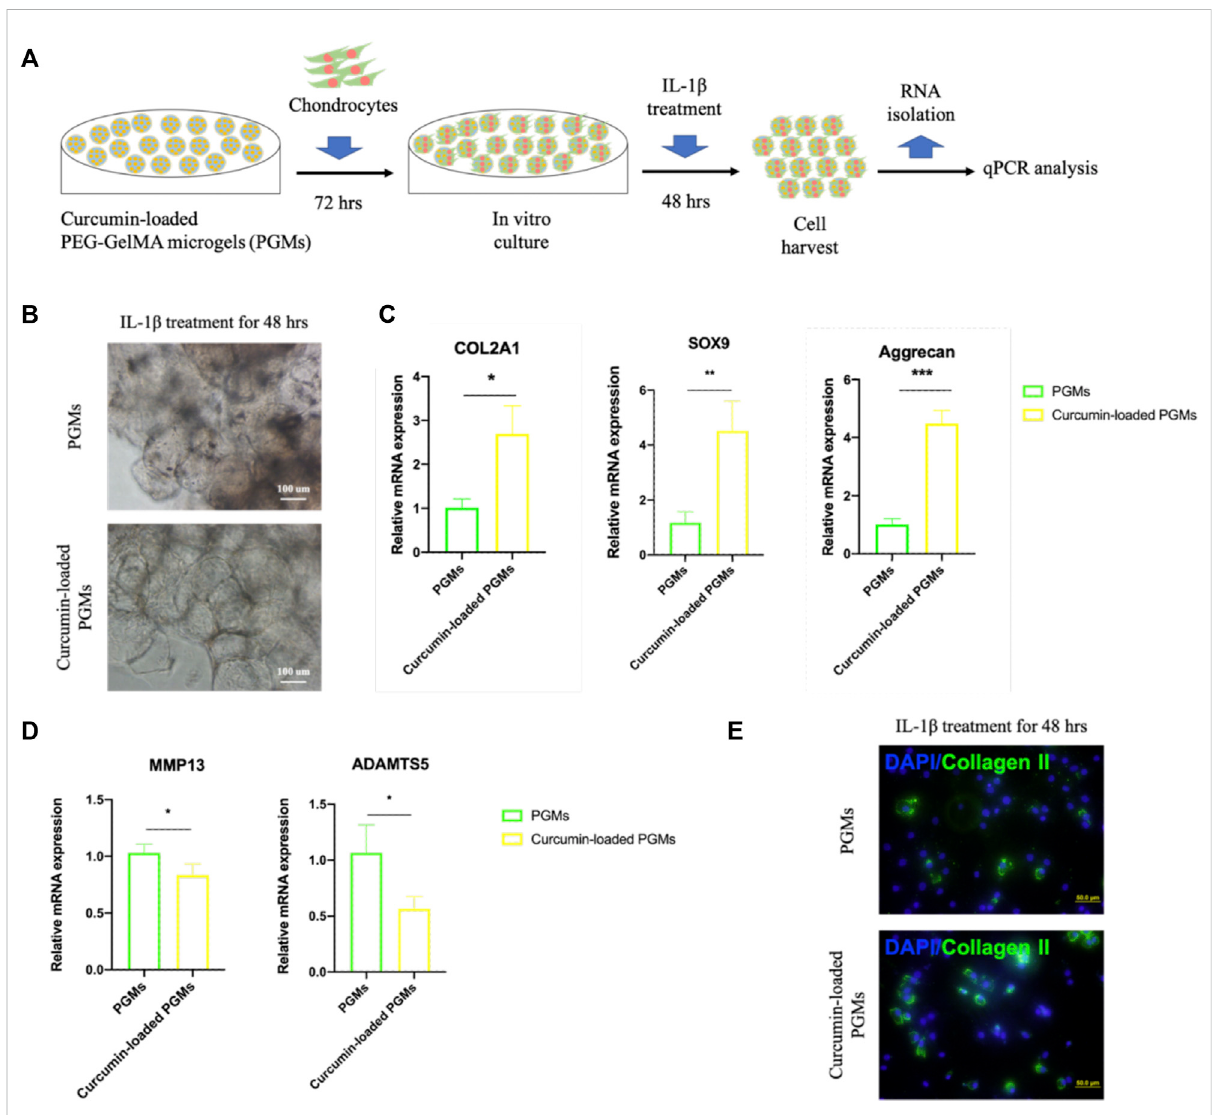
FIGURE 4 The amelioration of chondrocyte in fl ammation with curcumin-loaded PEG-GelMA microgel (PGMs). (A) Schematic of human chondrocytes cultured on the curcumin-loaded PEG-GelMA microgel (PGMs) for in vitro culture and further IL-1 β stimulation (10 ng/ml). (B) The bright- fi eld images ofcultured chondrocytes after IL-1 β treatment inthePGMsand curcumin (5 µM)-loadedPGMsgroups,respectively. Scale bar=100 μ m. (C) Quanti fi cation of the expression of phenotypic genes (COL2A1, SOX9, Aggrecan) for chondrocytes, and (D) Quanti fi cation of the expression of in fl ammatorygenes(MMP13,ADAMTS5) forchondrocytes.(Mean± SD; p p < 0.05, pp p < 0.01; ppp p < 0.001; biologicalreplicates n =4pergroup). (E) Immunostaining of Collagen II protein expression of the chondrocytes (sub-cultured on cover slip for 2 days) after IL-1 β treatment in the PGMs and curcumin-loaded PGMs, respectively. Scale bar = 50 μ